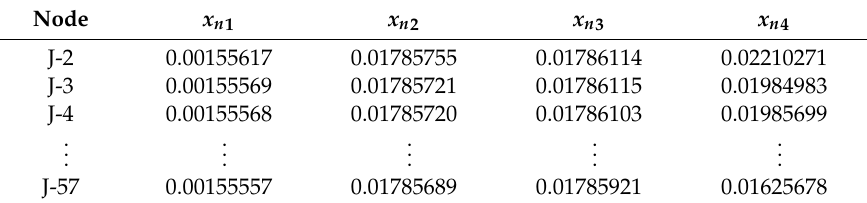
Table 4. Normalized values.